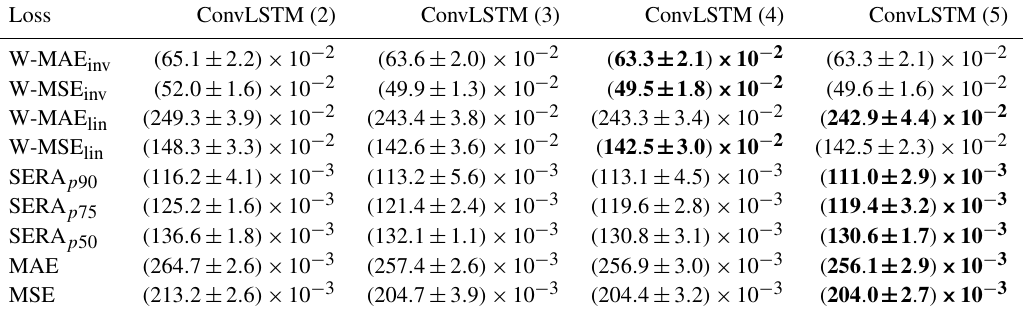
Table 2. Minimum validation loss as obtained by the ConvLSTM network with the number of layers ranging from two to five (denoted in brackets) and trained with each different loss function. Values are presented as the mean ± 1 standard deviation from the 4-fold cross- validation. The lowest minimum validation loss reached, and thus the optimal network architecture, is emphasised in boldface for each loss function. Where multiple architectures obtained the same minimum validation loss, the simpler architecture is given